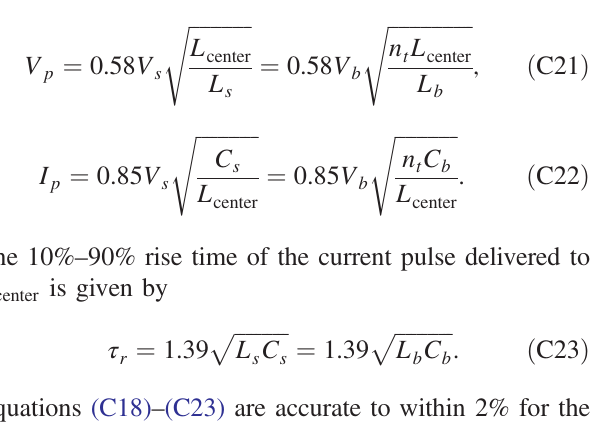
p L =L n t b center C =L n t b center